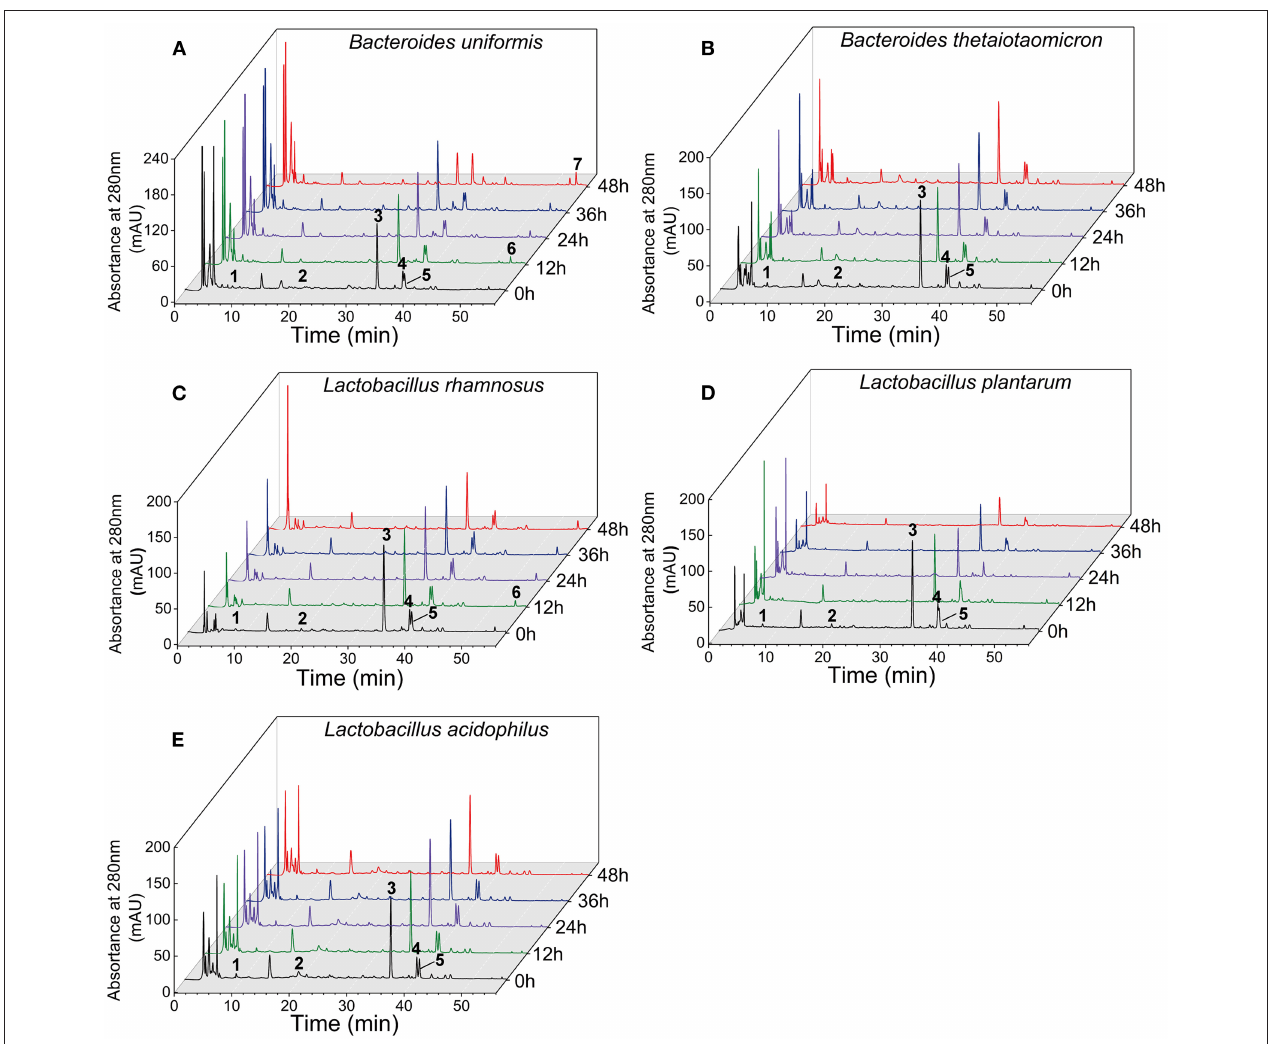
FIGURE 3 | Chromatograms of the supernatants of five gut microbial cultures during fermentation with LPP at 280nm. Peak 1, gallic acid; peak 2, ( + )-catechin; peak 3, quercetin-3- O -rutinose-7- O - α -L-rhamnoside (QRR); peak 4, ferulic acid; peak 5, rutin; peak 6, quercetin; peak 7,